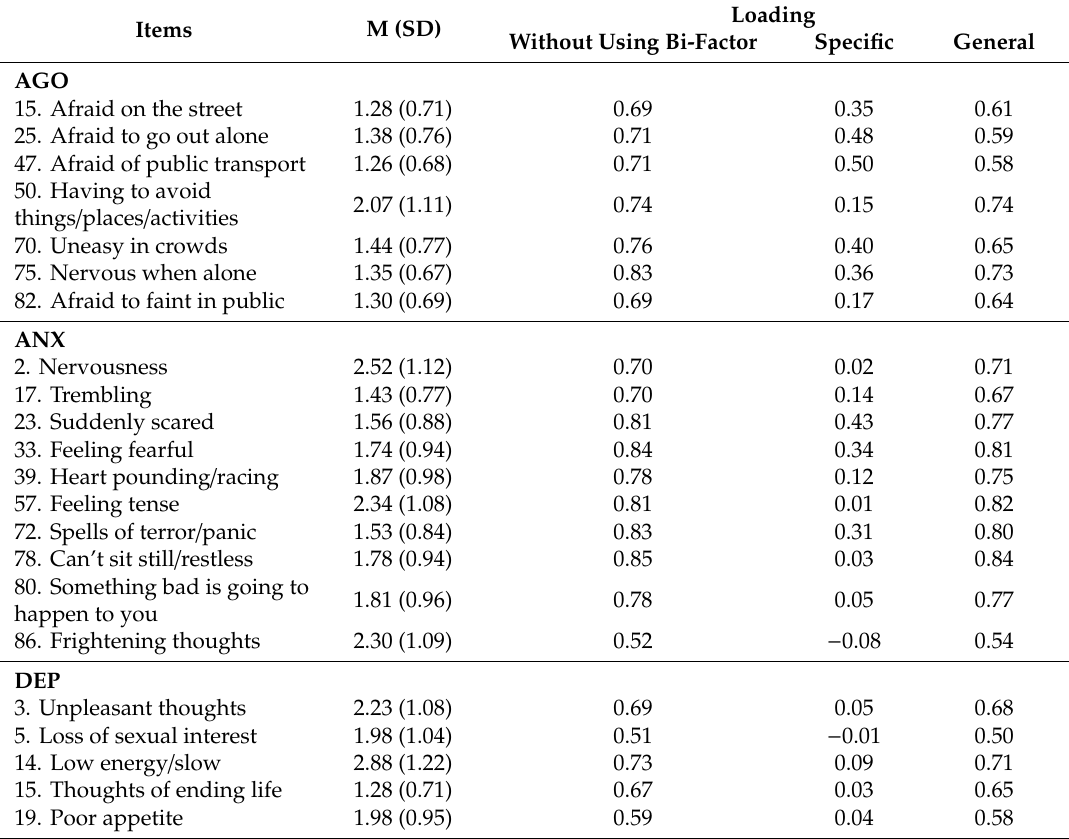
Table 4. Item properties of